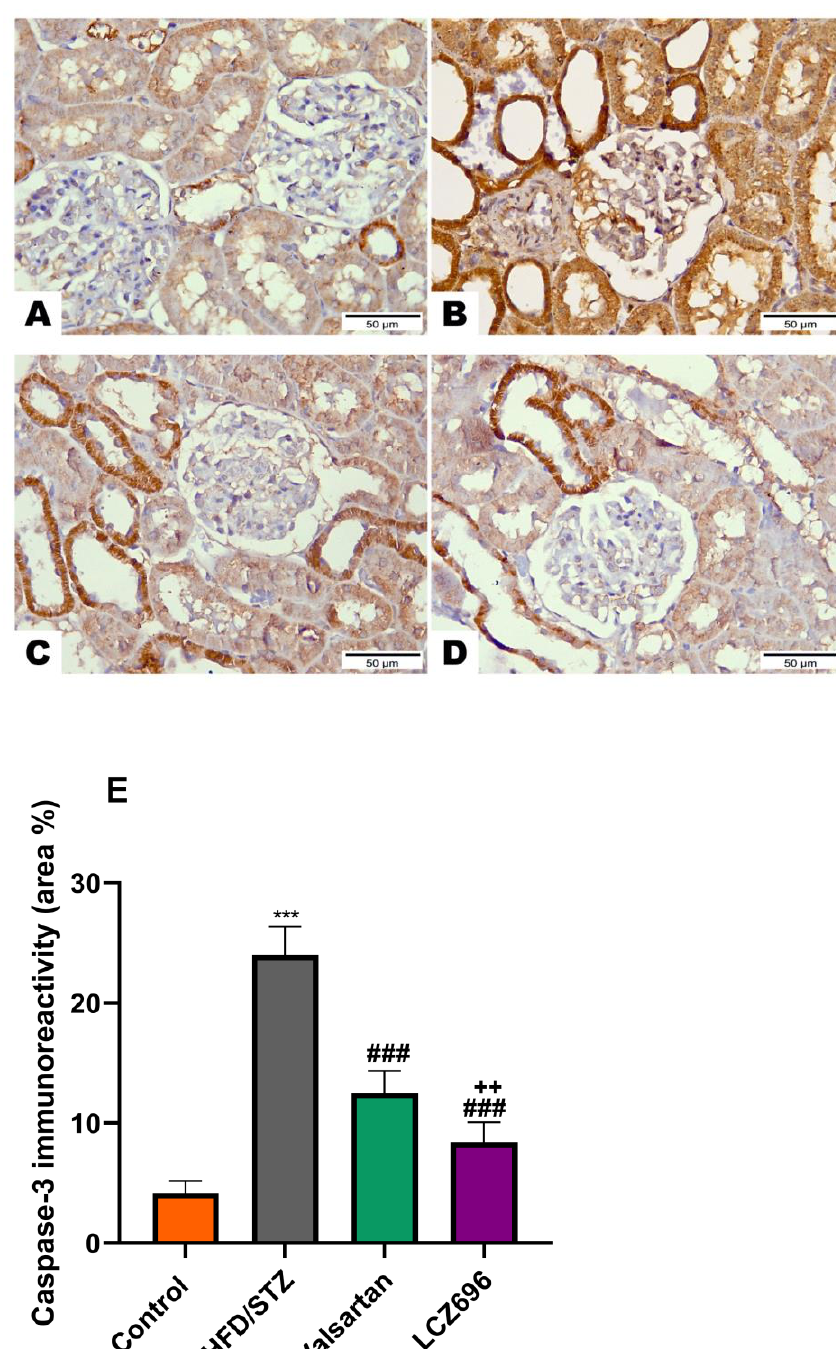
Figure 9. The effects of LCZ696 or valsartan on renal apoptosis marks in HFD/STZ-induced diabetic rats. A representative photomicrograph of renal cortex showing caspase-3 immunohistochemistry expression in different study groups. ( A ) control, ( B ) HFD/STZ, ( C ) valsartan-treated group, and ( D ) LCZ696- treated group. Area percent of immunoreactivity of caspase-3 were quantified ( E ), ( n = 3); data are presented as mean ± SEM, *** p < 0.001 versus control; ### p < 0.001 versus HFD/STZ; ++ p < 0.01 versus valsartan (scale bar 50 µm).